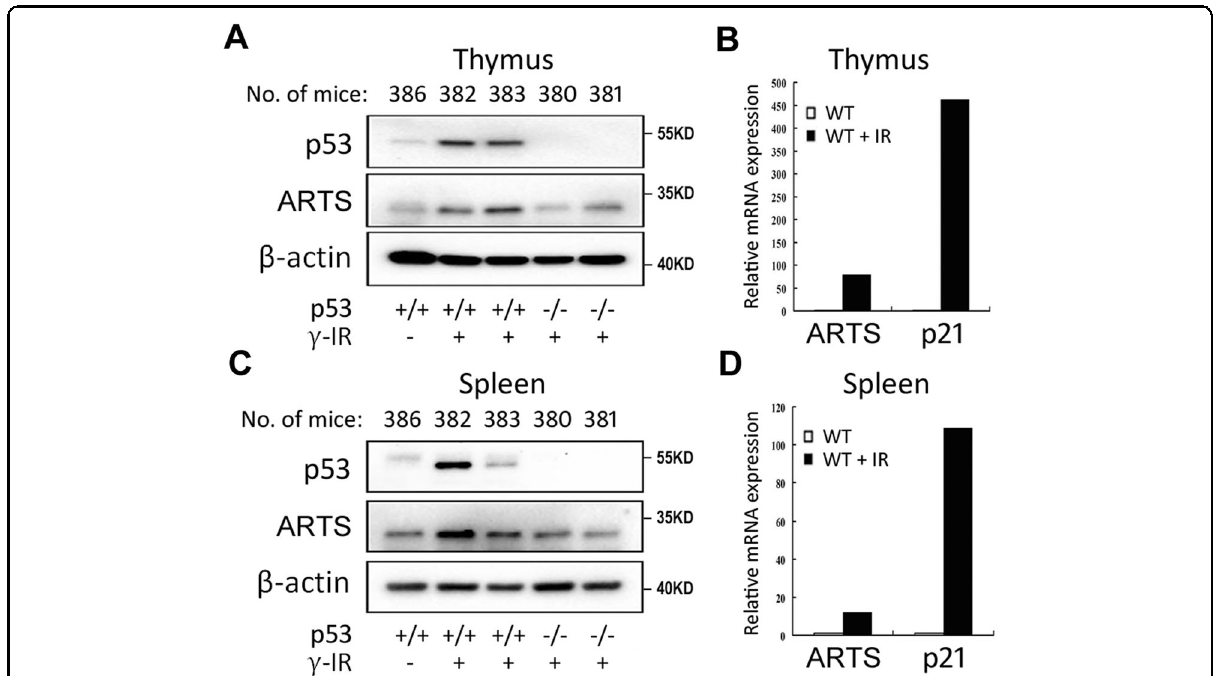
Fig. 2 ARTS expression is induced by γ -irradiation through p53 in mice. A , B ARTS mRNA ( A ) and protein ( B ) expression is elevated in the irradiated murine thymuses. The irradiated mice were sacri fi ced, and the thymuses were freshly harvested and subjected to IB or RT-qPCR analysis. C , D ARTS mRNA ( C ) and protein ( D ) expression is elevated in the irradiated murine spleens. The irradiated mice were sacri fi ced, and the spleens were freshly harvested and subjected to IB or RT-qPCR